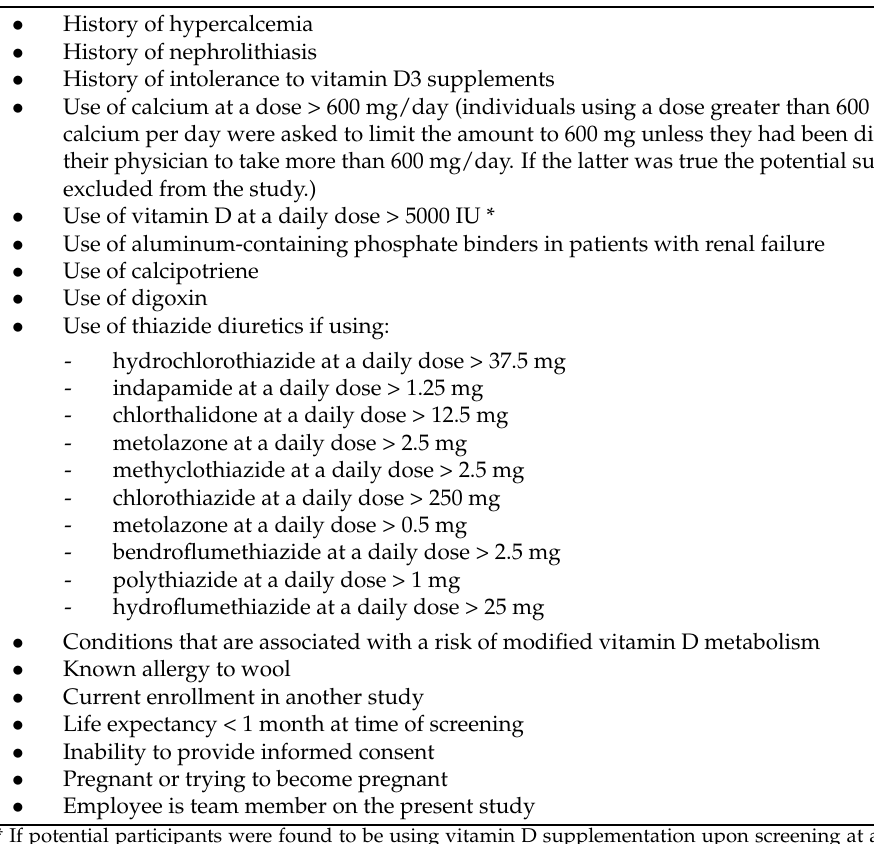
Table 1. Exclusion